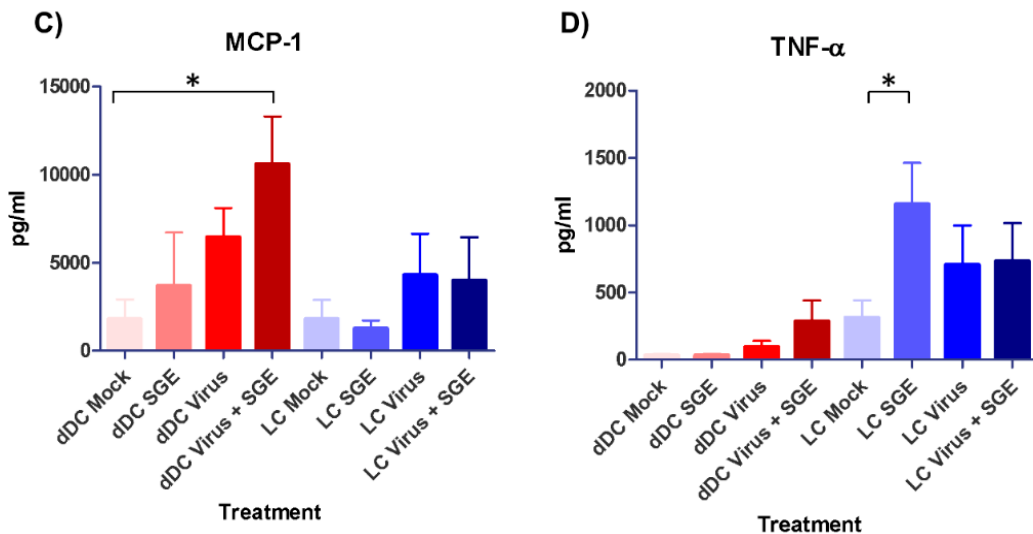
Figure 3. Cytokine and chemokine responses of mock and treated skin APCs. Human dDC and LC were studied using a multiplexed antibody/analyte detection assay. Cytokines ( A , D ) and chemokines ( B , C ) were detected by harvesting mock and treatment cell ( n = 5) clarified supernatants at 24 hpi after infection with CCHFV (strain IbAr 10200) and treatment with or without SGE; and run in technical duplicate on a Luminex bead-based multiplex system with kit provided control standards for pg/mL determinations. Significance between mock and indicated treatment groups at p < 0.05 is designated with an asterisk (*) symbol.